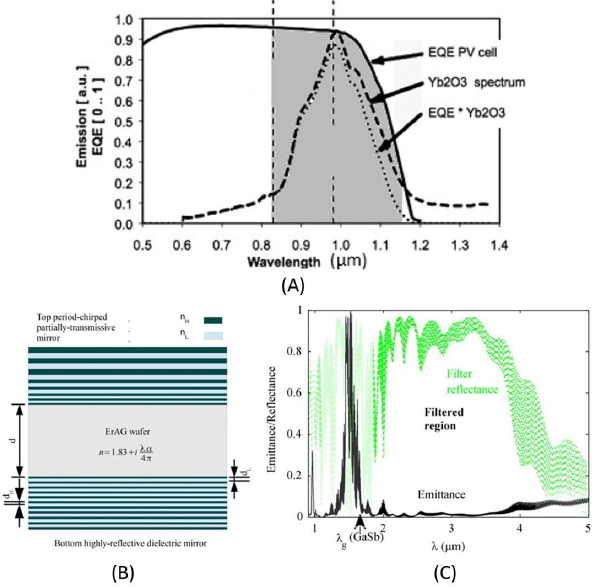
Fig. 7. Rare-earth emitters. (A) Yb 2 O 3 emission and the external quantum eflciency (EQE) spectrum of Si PV cell. The convolution with the Yb 2 O 3 spectrum is shown between 0.6 and 1.4 µm wave- length [67]. (B) A schematic of the high eflciency rare-earth emitter proposed in with chirped-mirror. The bottom dielectric mirror is a QWS with reflection centered at 1.47 µm. The top dielectric mir- ror has an exponentially chirped period with up to 26 layers that reflects all the wavelengths from 2 to 4 µm. The ErAG wafer is as- sumed to be much thicker than the dielectric layers surrounding